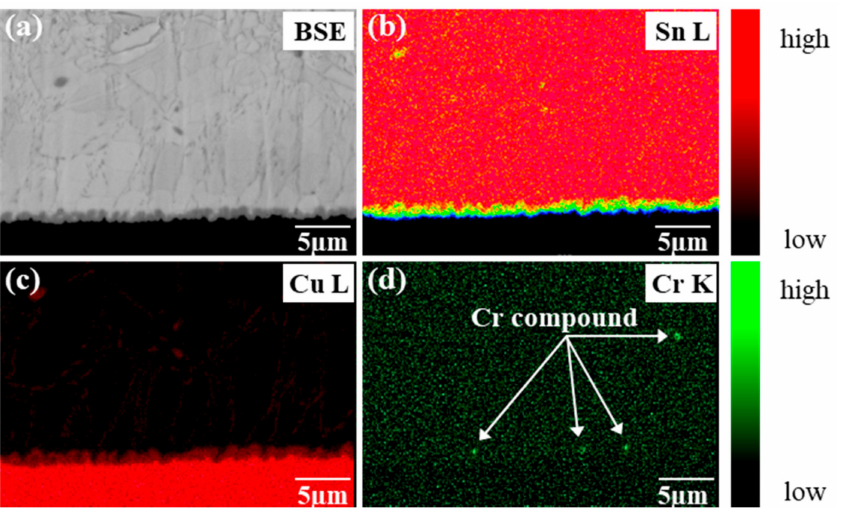
Figure 9. EPMA electron mapping of the Sn-0.7Cu-0.2Cr solder joint ( a ) SEM image of the mapping region. Elemental maps of ( b ) Sn, ( c ) Cu, ( d ) Cr.